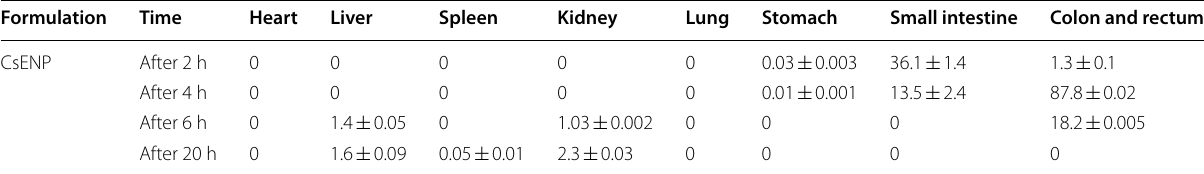
Data are expressed as percentage released of total radioactivity in nanoparticles administered The values represent mean